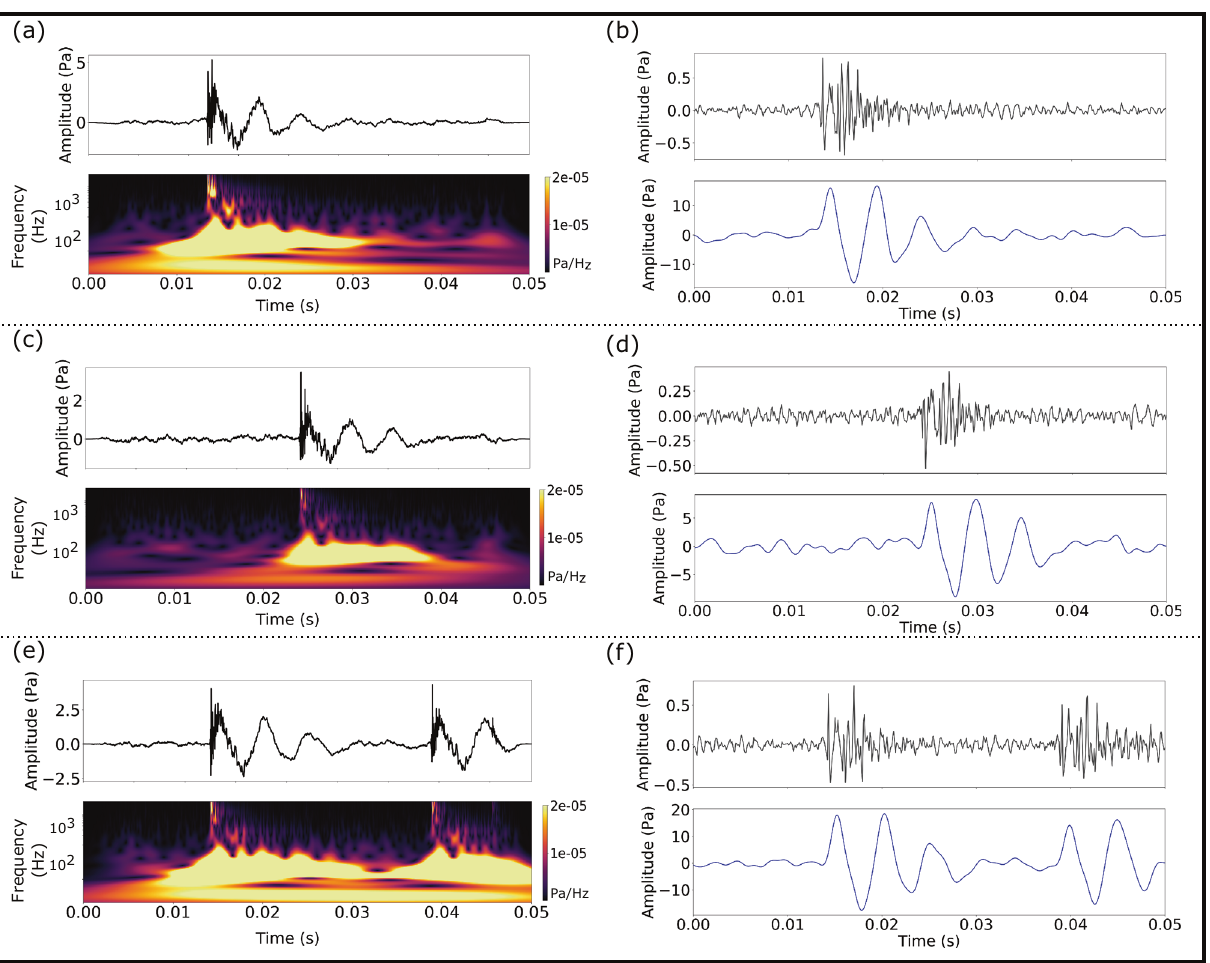
Fig. 2 Time-frequency characteristics of bubble events. a , c , e Typical waveform and corresponding time-frequency evolution (wavelet transform) of four bubbles ( e contains two events). b , d , f Filtering to isolate the impulsive and resonant components of the waveforms. Top panel (black) shows the impulsive onset (high-pass fi ltered above 600 Hz), and bottom panel (blue) shows the resonance of ~100 – 200 Hz (low-pass fi ltered below